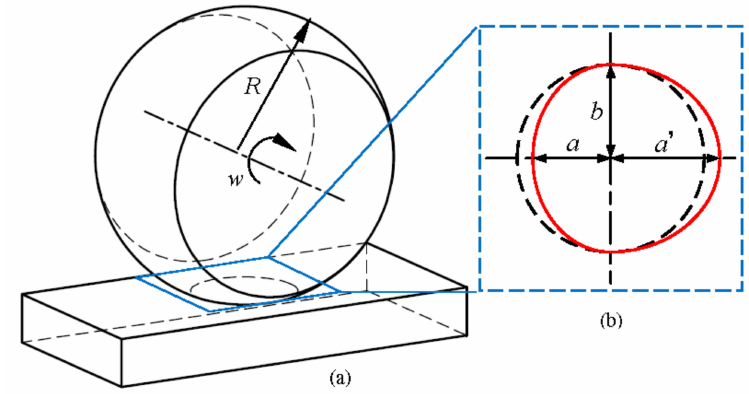
Figure 3. Contact model. ( a ) 3D model, ( b ) contact